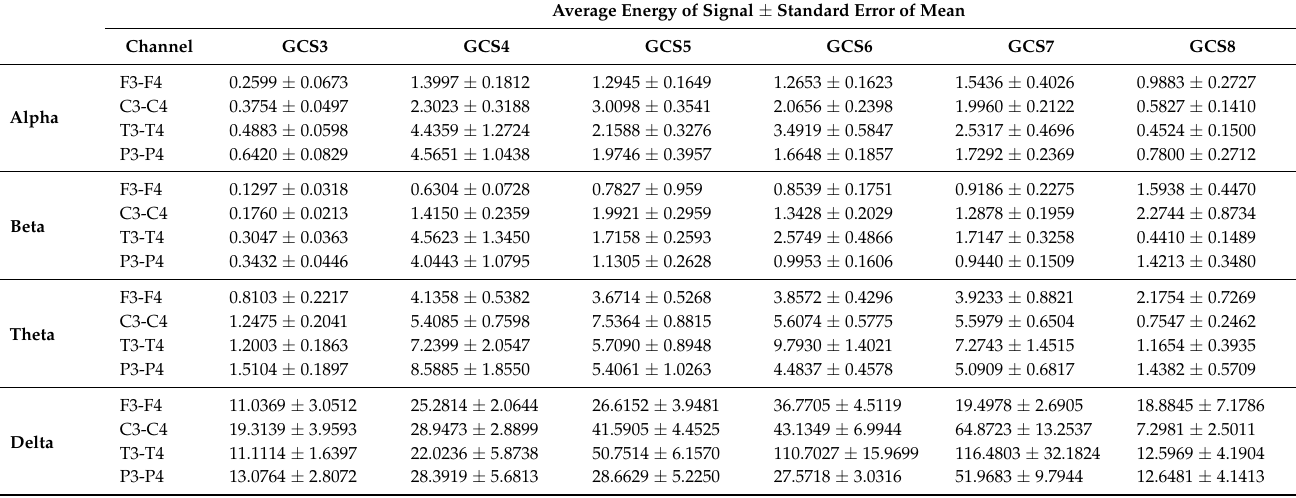
Table 4. Energy values of different